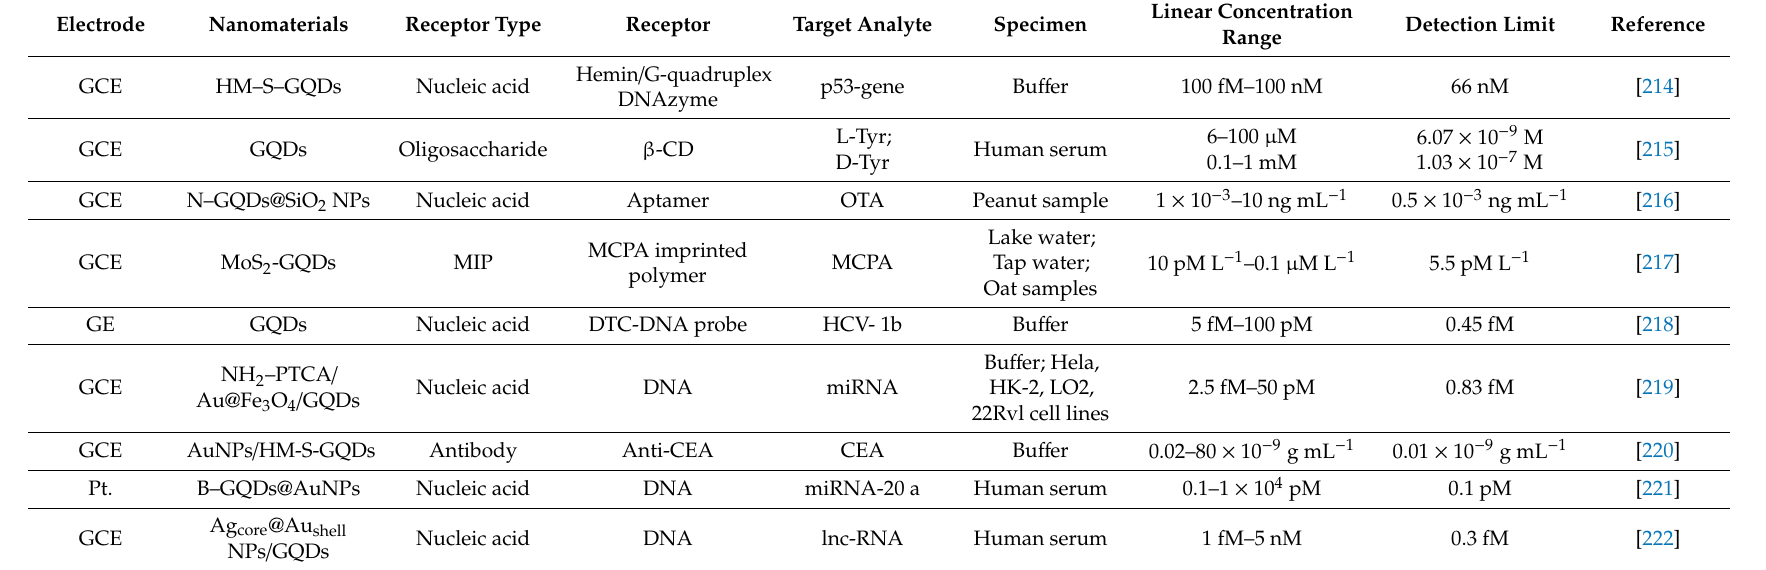
Table 3. Various other ECL-sensors for biomedical applications (2015